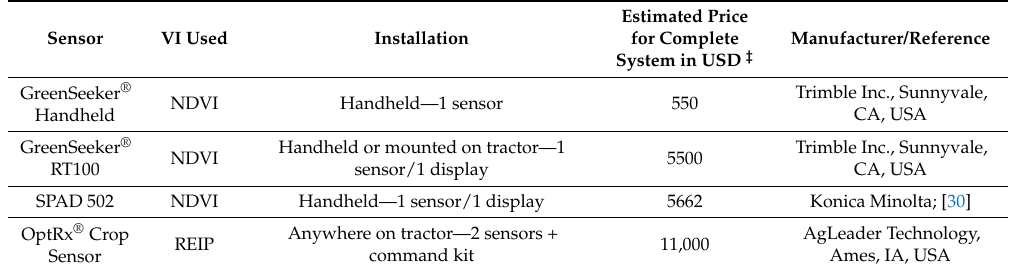
Table 1. Overview of a series of currently available site-specific crop management (SSCM) N sensors.